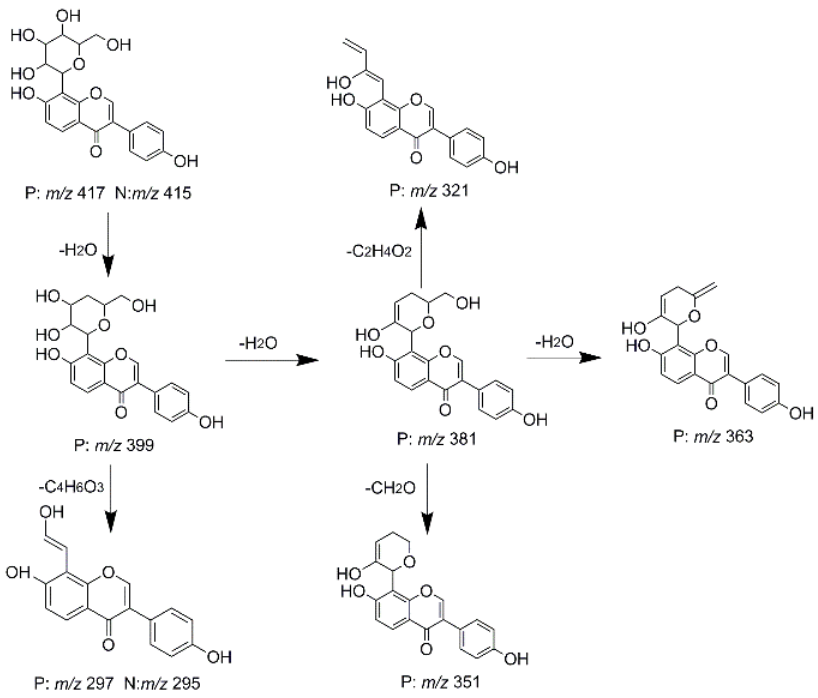
Figure 5. The fragmentation patterns of puerarin (P for the positive ion mode and N for the negative ion mode).